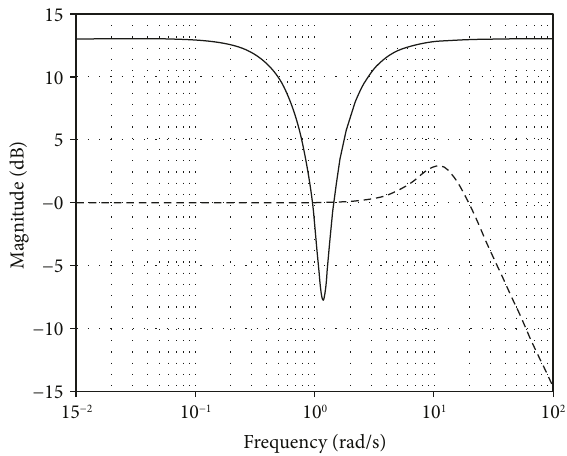
Figure 19: Visualization of robust stability condition in alternative form (13) — upper bound 1/ W M j ω (solid line) and complementary sensitivity T 0 j ω (dashed